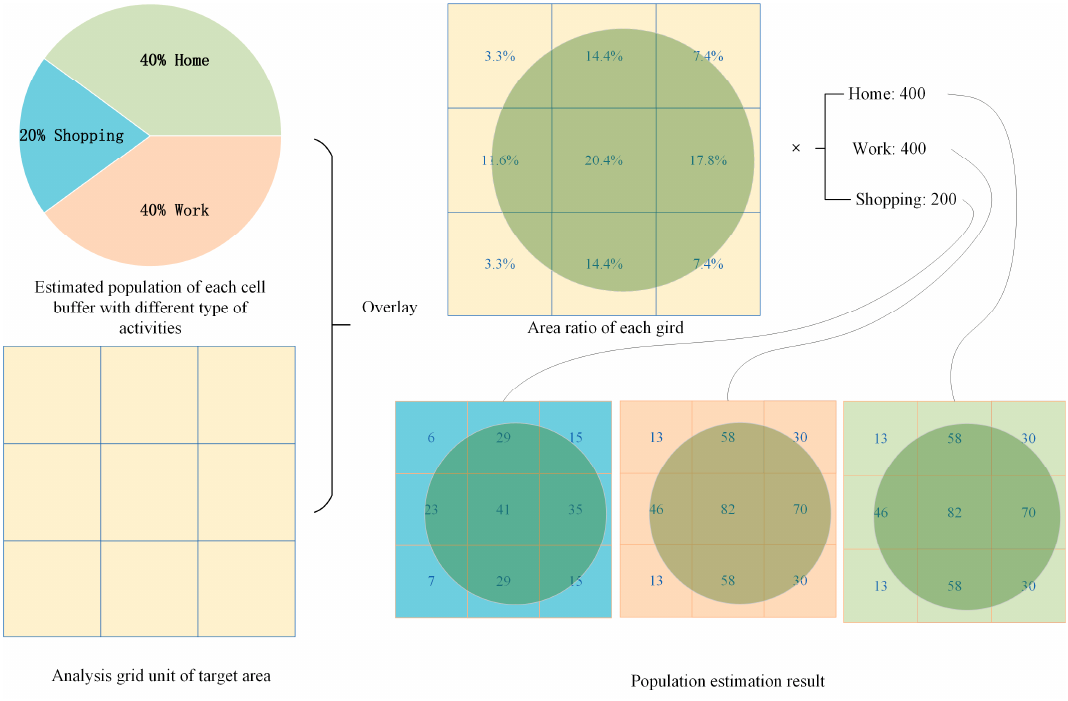
Figure 2. The implementation process of area weight interpolation method for activity distribution estimation, using sample data.